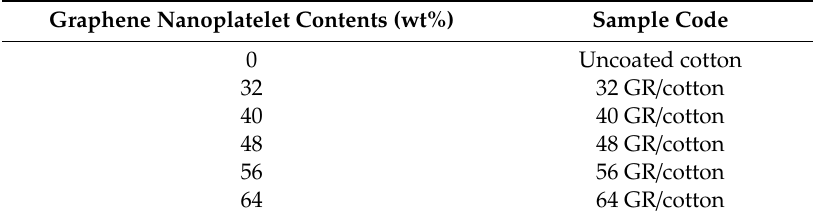
Figure 1. Preparation process of fabric heating element. Table 1. Sample codes of fabricated samples coated with graphene nanoplatelet / poly(vinylidene fluoride- co -hexafluoropropylene) (PVDF-HFP) composite with various high-content of graphene nanoplatelet.